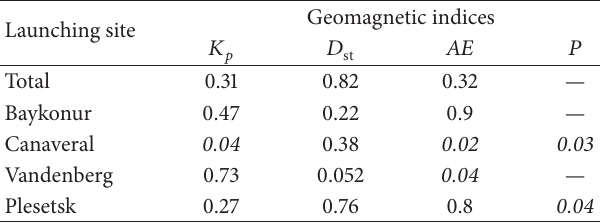
Table 2: The attained levels of significance ( 𝑃 -values) for rela- tionships between launch failures at various launch sites and geo- magnetic activity (italic data indicate the occurrence of statistically significant relationships if apriori significance level 𝛼 has been chosen to be